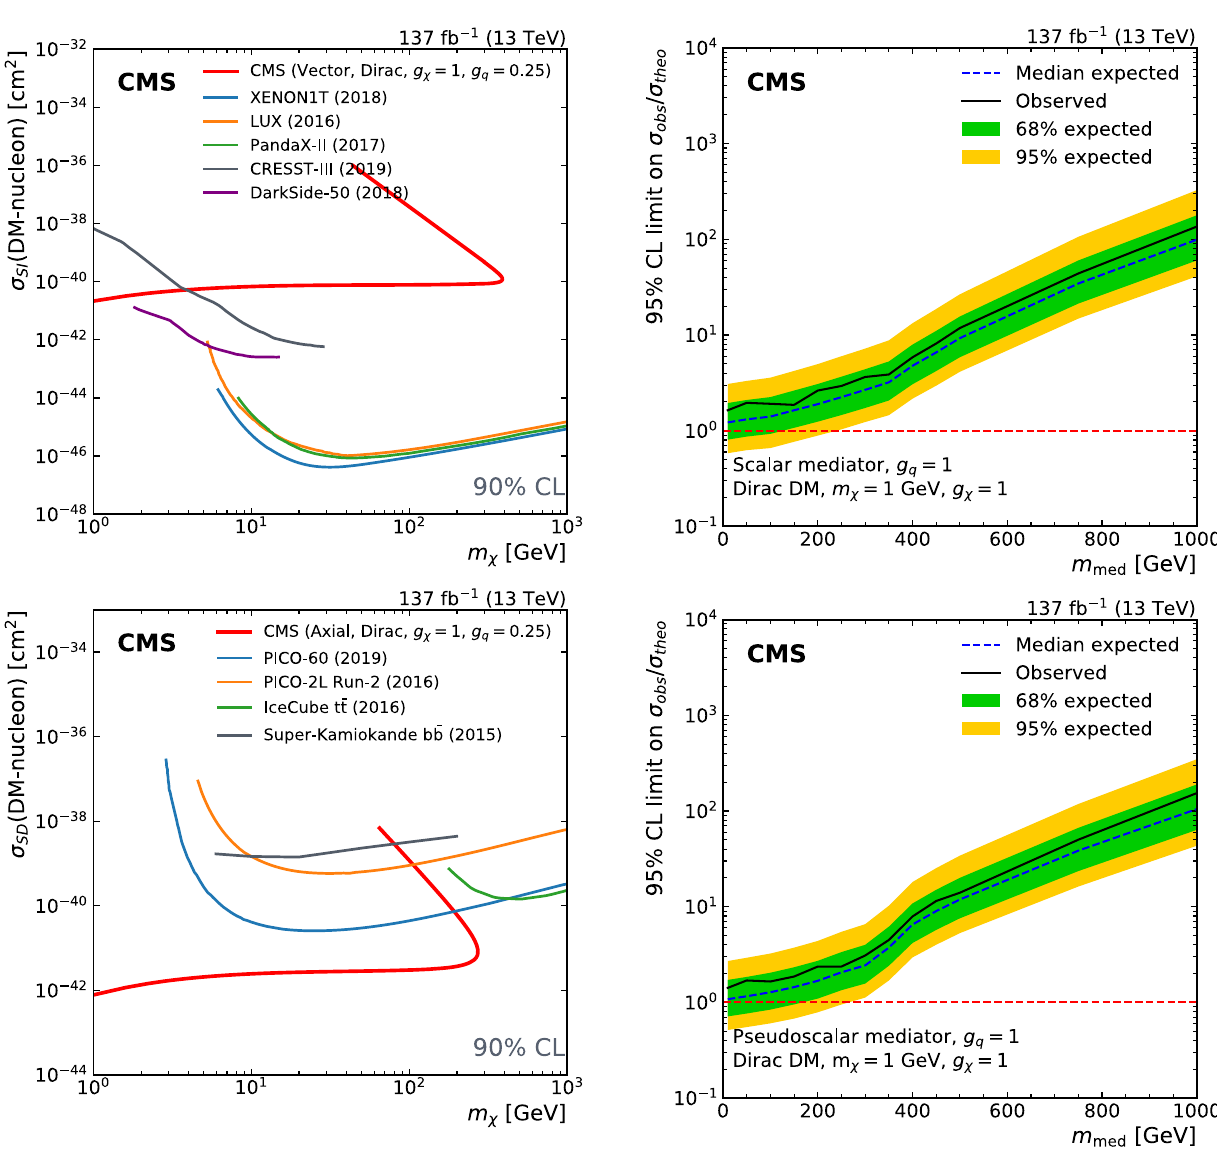
Fig. 7 The 95% CL upper limits on the cross section for simplified DM models with scalar (upper) and pseudoscalar (lower) mediators. The coupling to quarks is set to g q = 1, the coupling to DM is set to g χ = 1 and the DM mass is m χ =